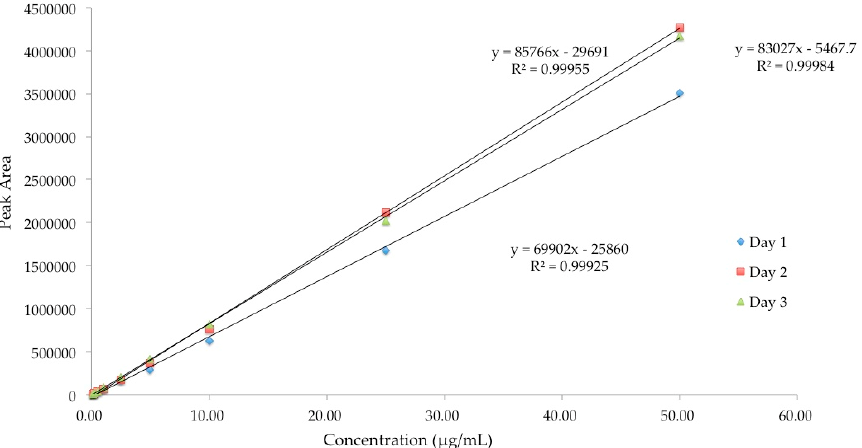
Figure 3. Linearity of HPLC method for analysis of lorazepam.